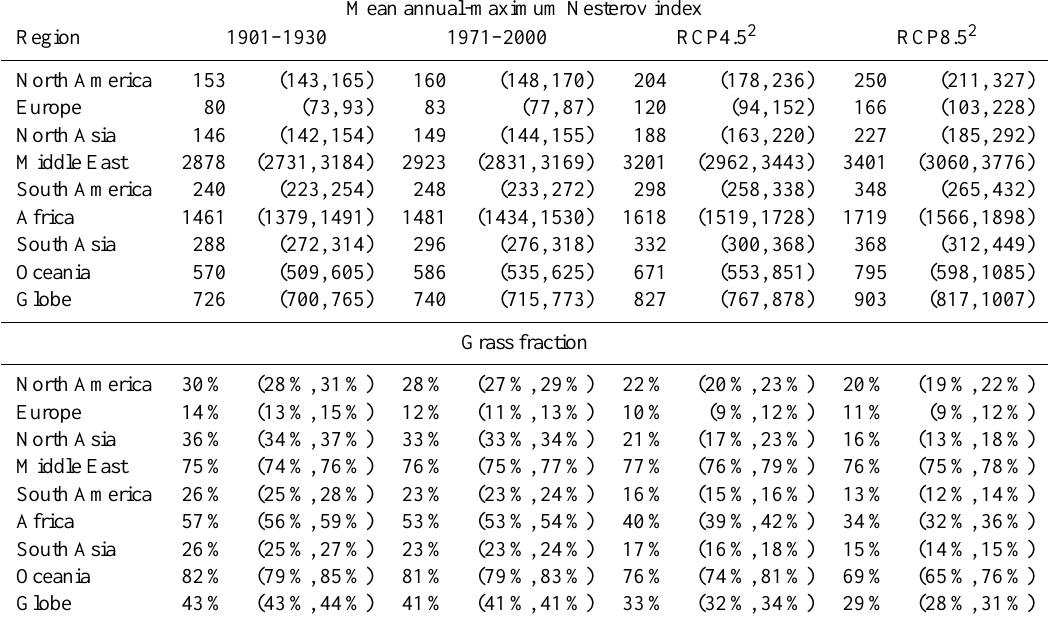
Table 3. Changes in climatic and vegetation fire risk 1